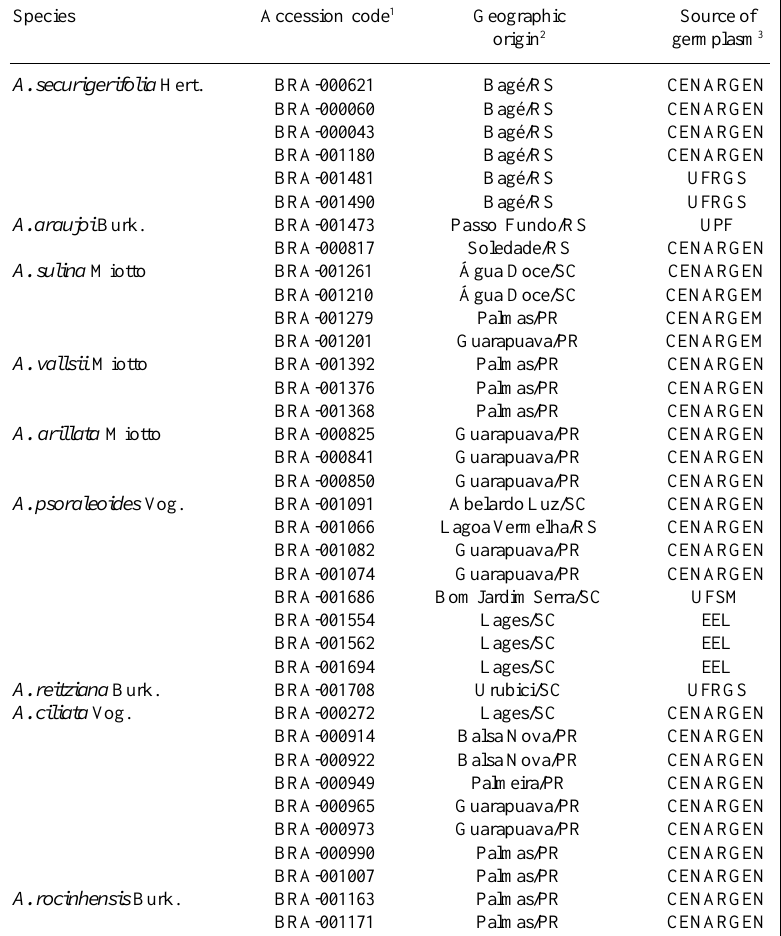
Table II - List of Adesmia accessions utilized for the observation of the mode of reproduction (Experiment 2